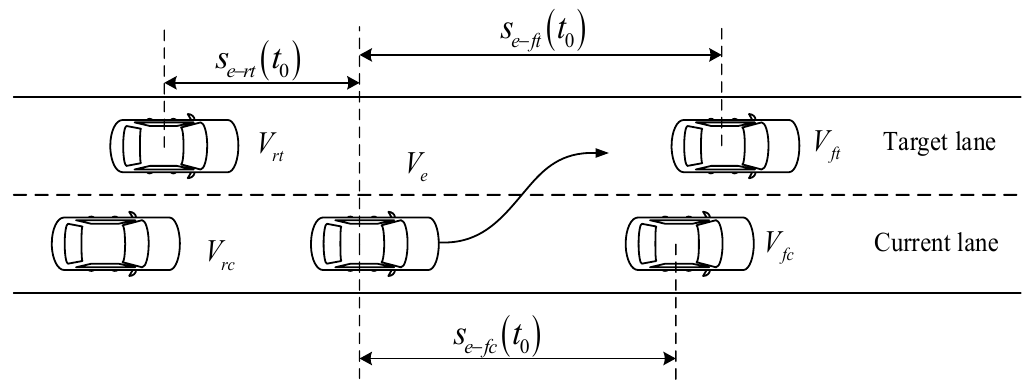
Figure 1. Schematic diagram of vehicle lane change. According to the experience, the lane change time ∆ t was selected as 4~8 s, and the longitudinal displacement of lane change ∆ x was 60~135 m, in which the lane change time was 0.2 s as the simulation step and the longitudinal displacement was 2 m as the simulation step for the simulation experiment. The unconstrained lane changing trajectory cluster is obtained, as shown in Figure 2.